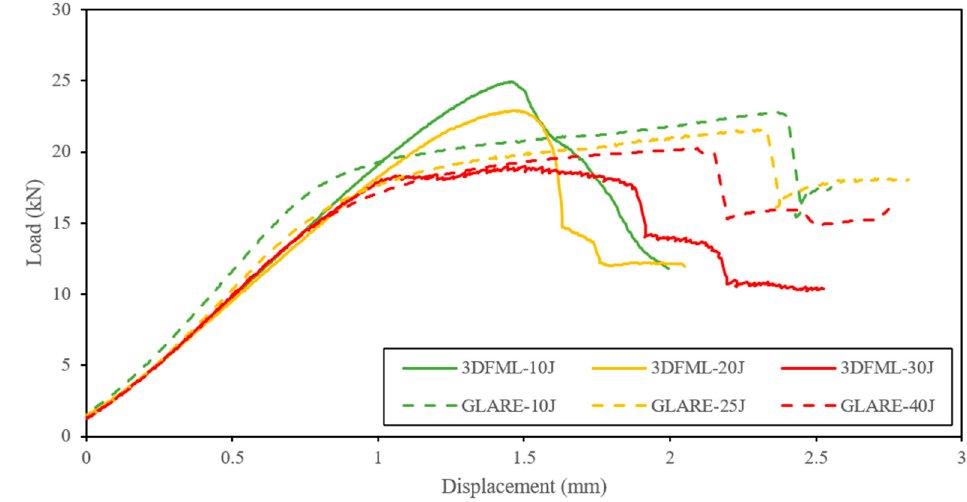
Figure 18. CAI test results.